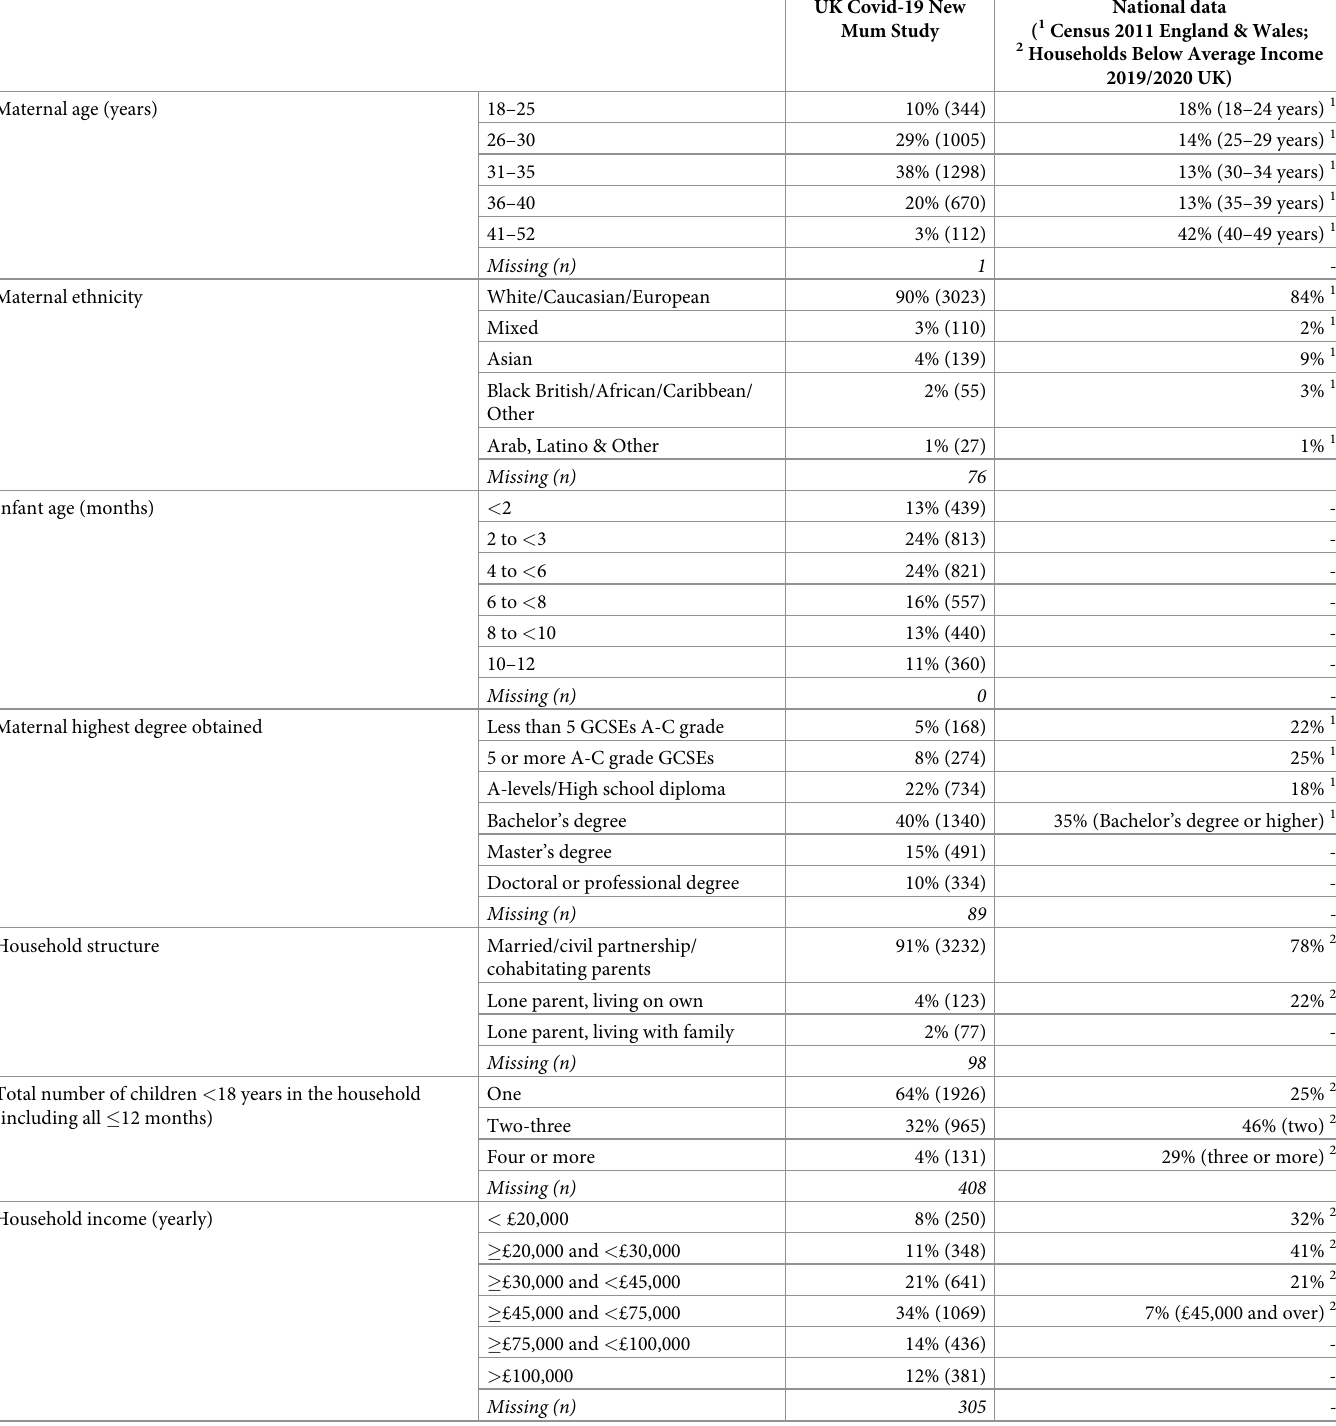
Table 2. Characteristics of mothers and infants in the UK COVID-19 New Mum Study (28 th May 2020-26 th June 2021); % (N =